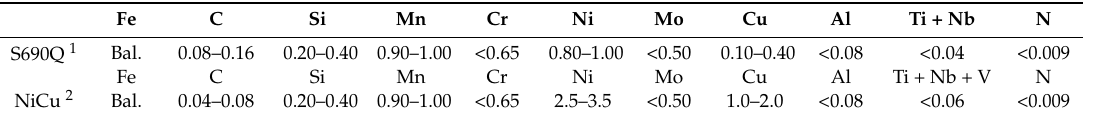
Table 1. The chemical compositions of studied offshore steels (in wt